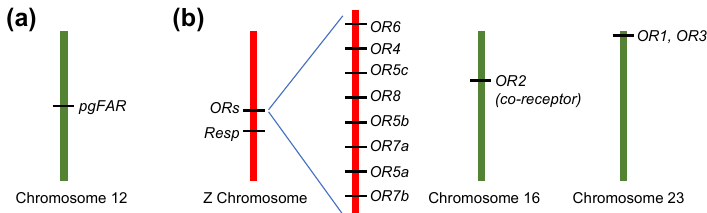
Figure 3. The production of female sex pheromones and male reception are physically unlinked in the European corn borer O. nubilalis (ECB), controlled by genes on different chromosomes. ( a ) The reversed ratio of pheromones in E and Z strains is controlled by one autosomal locus on chromosome 12 [35–37], which encodes fatty-acyl reductase in pheromone gland ( pgFAR ) with strain specific substrate specificities [7]. ( b ) The male response is controlled by a sex-linked quantitative trait locus (QTL), Resp, and an autosomal locus not linked to the female production locus [6]. The autosomal locus might correspond to the array of OR1 and OR3 located on chromosome 23 [37,39], whereas the sex-linked Resp locus is 15 cm distant from the large cluster comprised of eight PR genes at Z chromosome [40,41]. The co-receptor Orco (previously referred to as OR2) gene is located on chromosome 16 [39]. The total number of chromosomes in Ostrinia spp. is 31 [42].